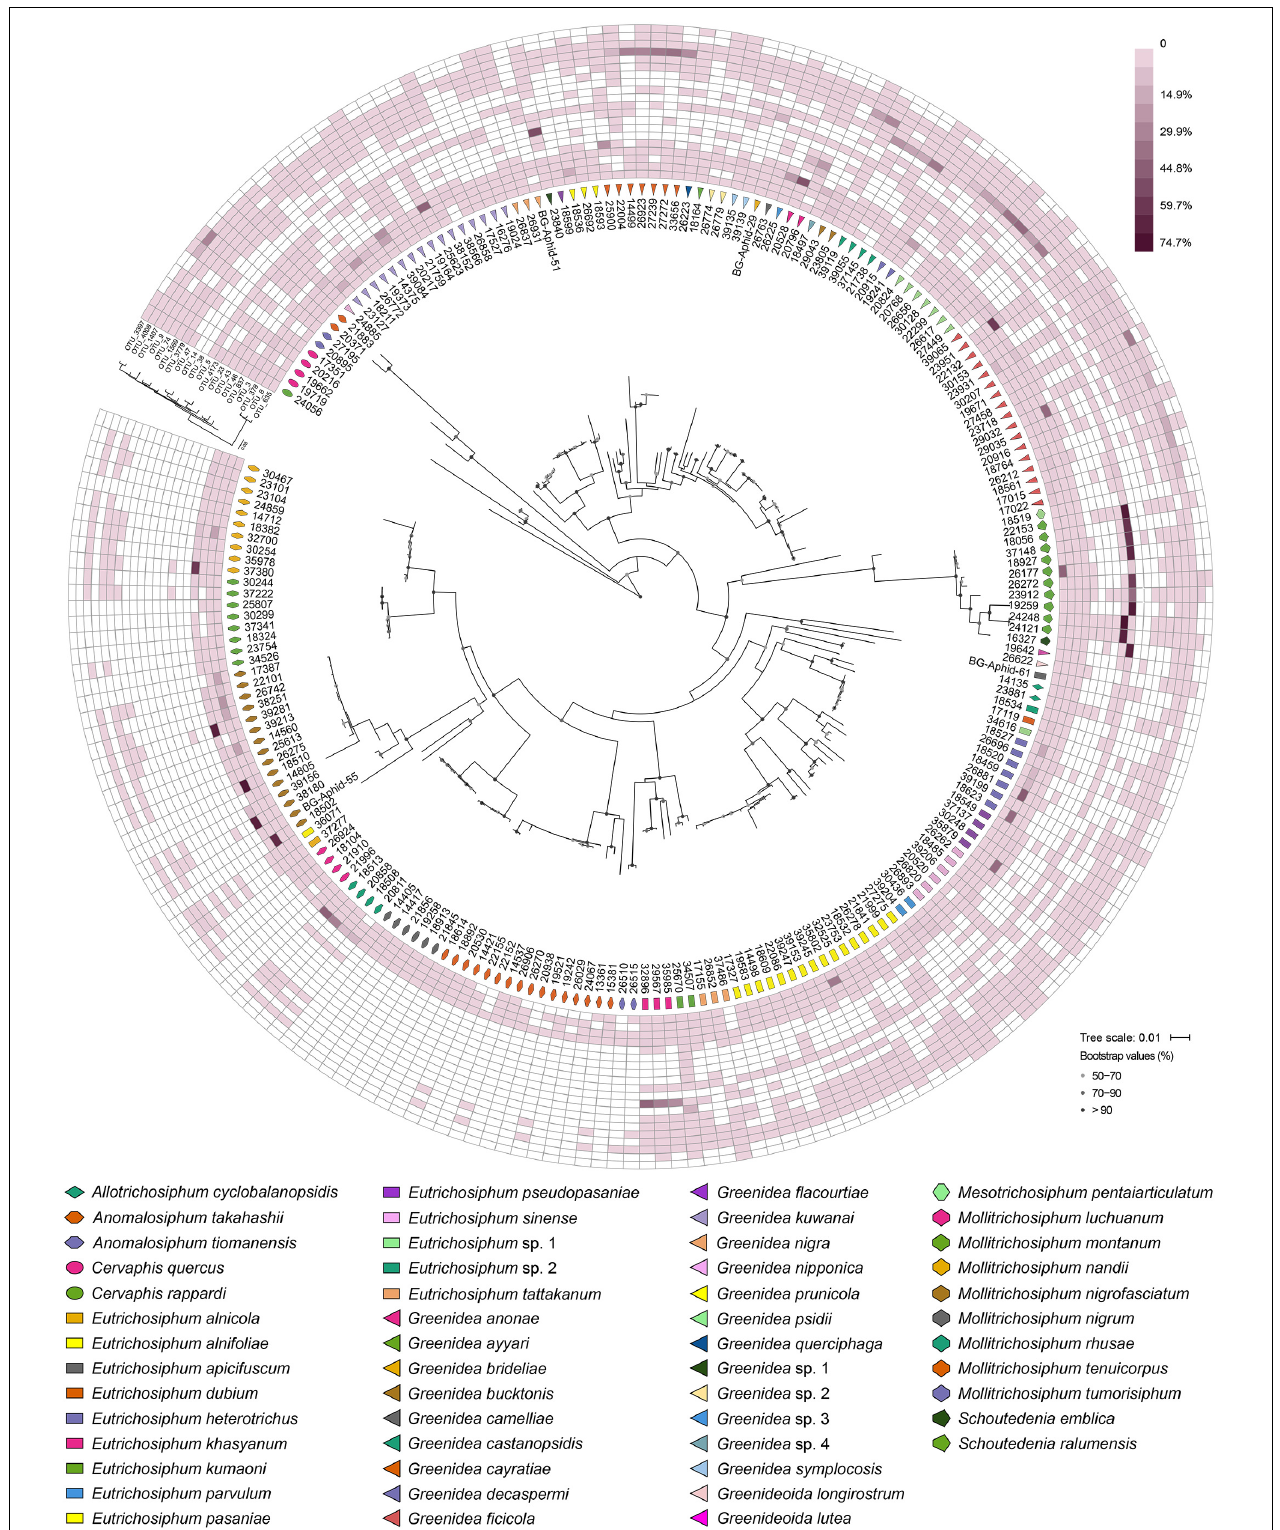
FIGURE 2 | Heatmap representing the distribution and relative abundances of Serratia symbiotica OTUs among Greenideinae aphids. The phylogenetic relationships of Greenideinae and S. symbiotica OTUs based on maximum-likelihood analyses are presented.